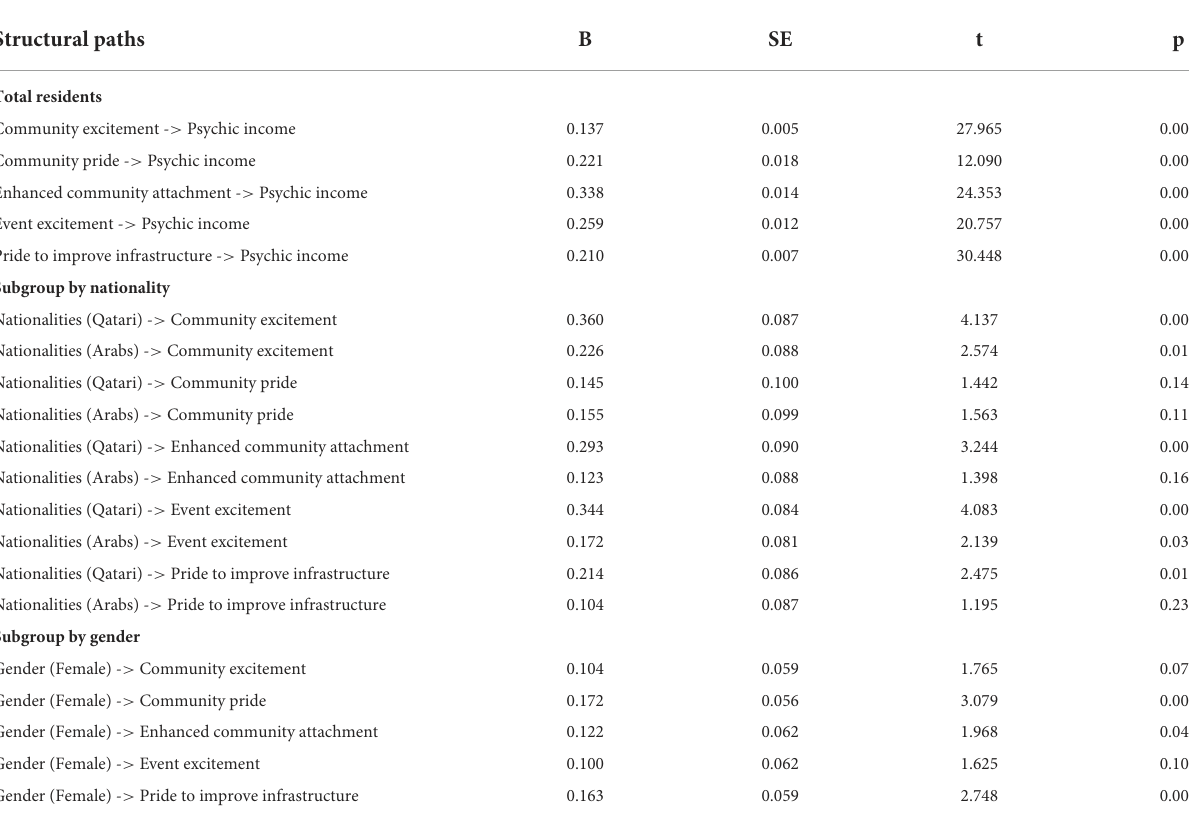
TABLE 2 Structural model